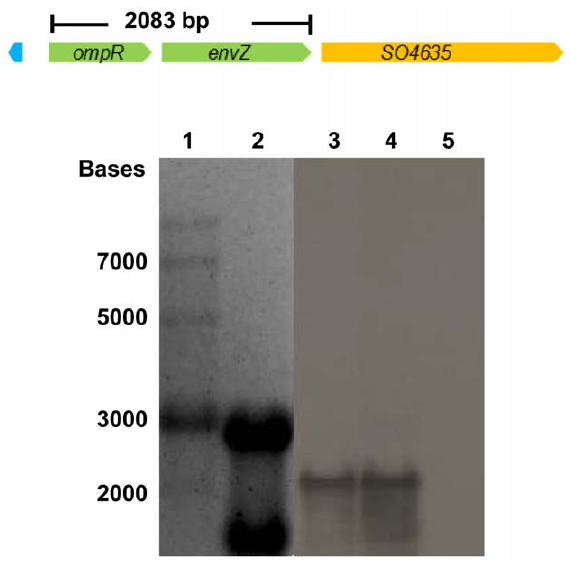
Figure 1. Northern blot assay of the ompR-envZ operon. Total RNA used in the analysis was from mid-exponential growing MR-1 cells. Organization of ompR-envZ and adjacent genes is shown. Lanes: 1, RNA ladder; 2, total RNA control (same amount of RNA stained with ethidium bromide); 3, RNA hybridized with probe specific for ompR ; 4, RNA hybridized with probe specific for envZ ; 5, RNA hybridized with probe specific for so4635 .